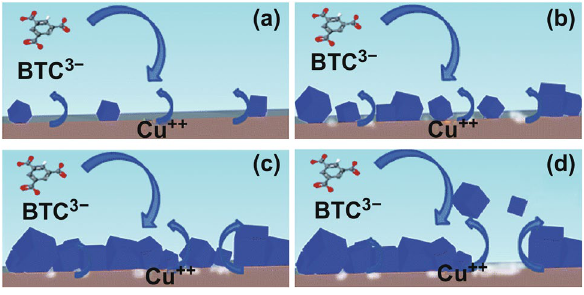
Fig. 29 Four phases of anodic deposition: a initial nucleation, b growth of MOF islands, c intergrowth, and d crystal detachment. Reprinted with permission from Ref. [73]. Copyright 2016, Royal Society of